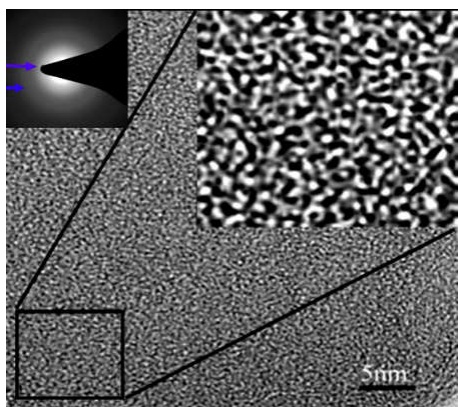
Figure 2. HRTEM image of disordered pore structure in pure CMS membrane [38].